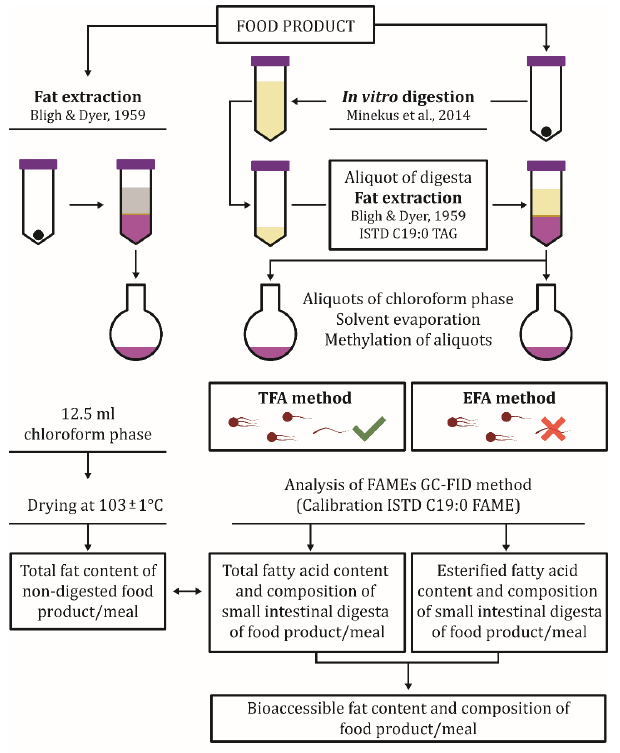
Figure 1. Protocol outline for harmonized sample preparation of in vitro small intestinal digest for the assessment of FFA release in food samples along with the protocol for fat content determination of the same input